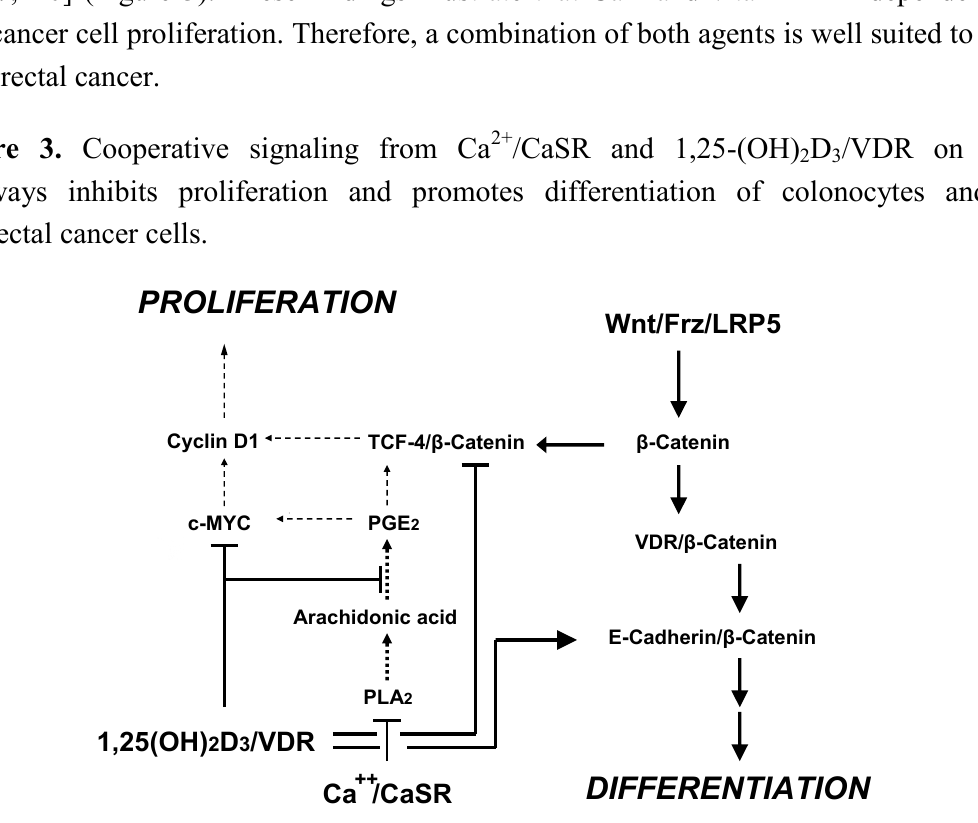
D /VDR on Wnt 2 3